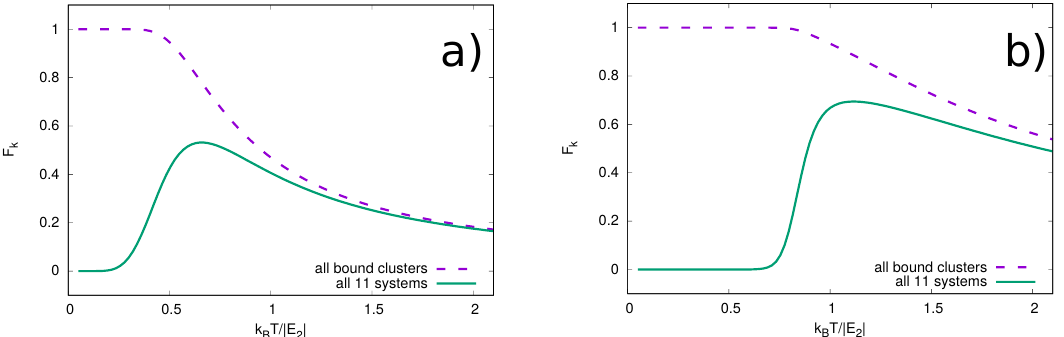
Figure 9. This figure shows the fraction of states with at least one bound cluster of any kind (’all bound clusters’) or the sum of all clusters that contain at least one 11-cluster (all 11 systems). The dipole strength is U = 5, and the confining frequency is chosen such that the oscillator length in the tubes is equal to twice the inter-layer distance. Panel ( a ) shows the one-particle-per-layer system and panel ( b ) shows the two-particle-per-layer